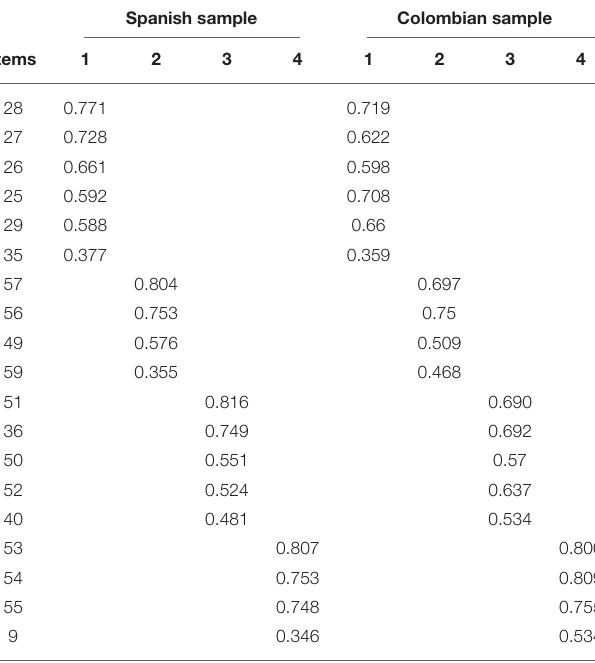
TABLE 2 | Weights for each item selected in the factors from the Colombian and Spanish samples. Spanish sample